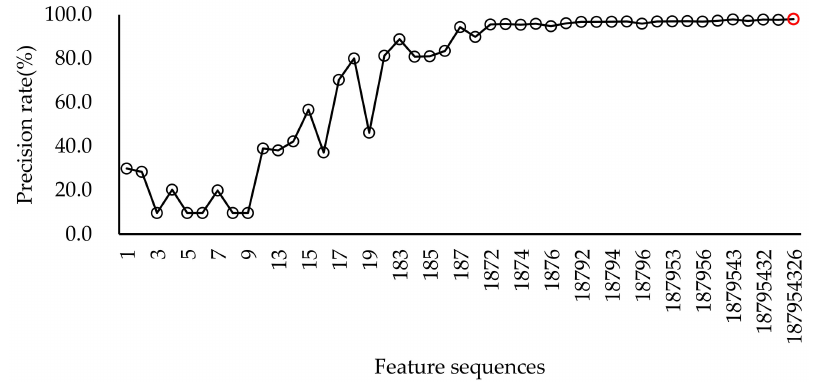
Figure 4. The plot of precision rate in di ff erent feature sequential selection. The red circle marks the maximum recognition rate.